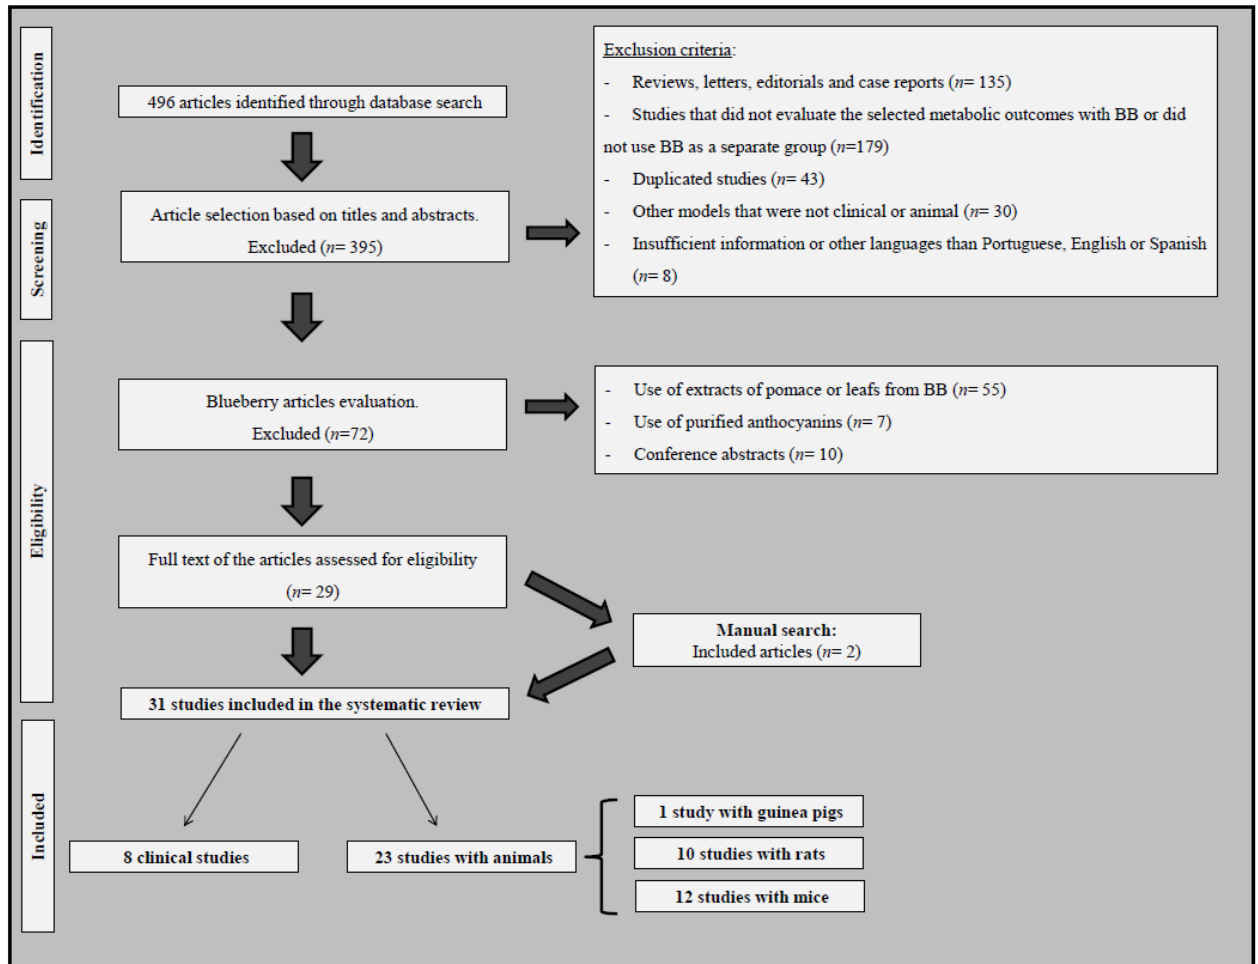
Figure 1. Flowchart illustrating the search strategy used in the systematic review.